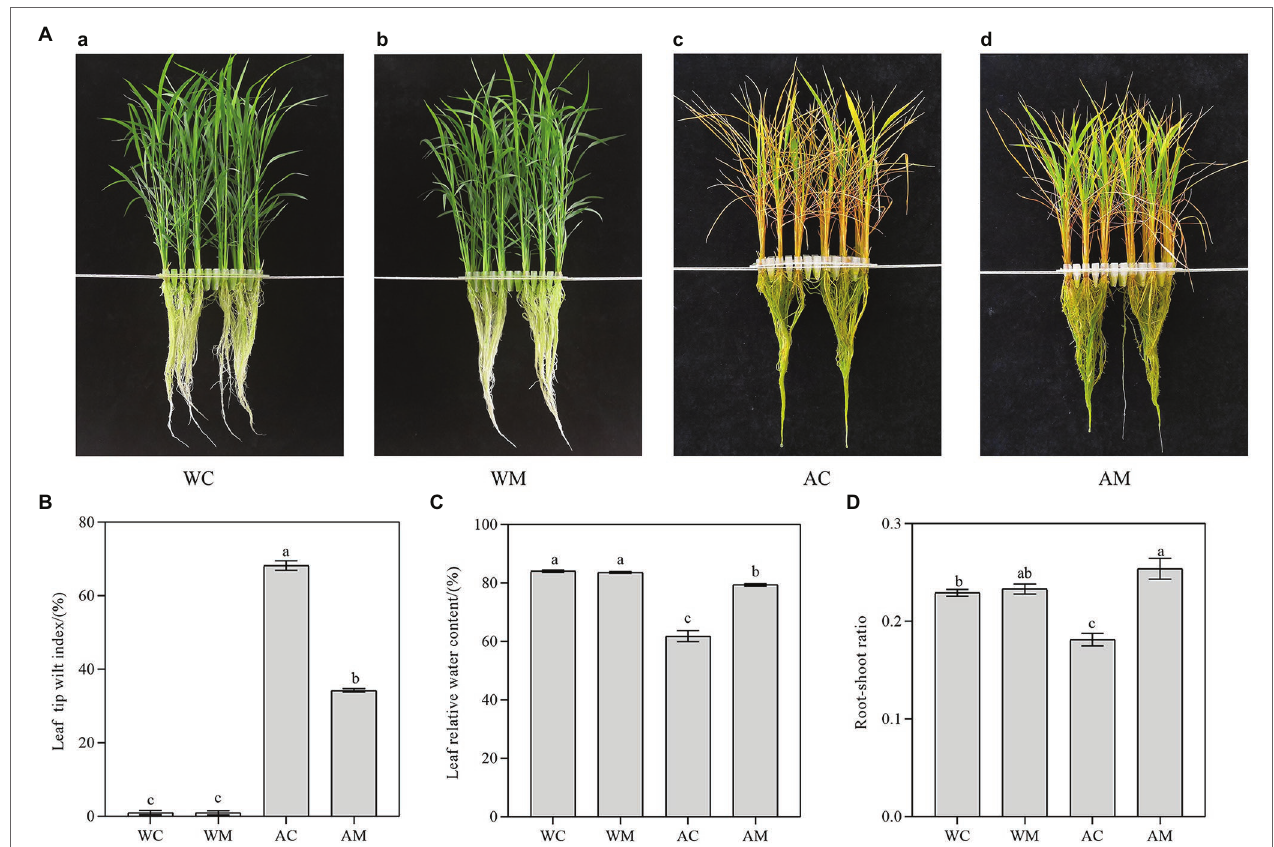
FIGURE 1 | Melatonin alleviated alkaline stress to rice seedlings. (A) Growth performance of rice seedlings under different treatments; (B) leaf tip wilt index; (C) leaf water content; and (D) root-shoot ratio. Data represent means ± SEs of three replicate samples. Different letters denote significant differences ( n = 3, and p < 0.05). WC, control; WM, control pretreated with MT; AC, alkaline stress; and AM, alkaline-stressed plants pretreated with